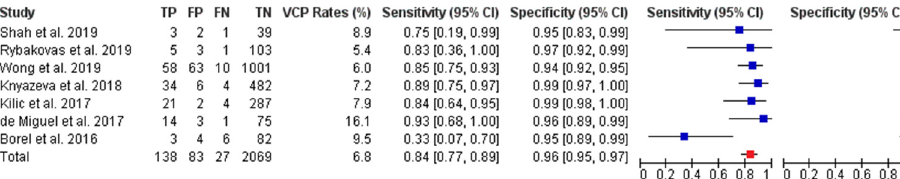
Figure 1. Forest plot of sensitivity and specificity of TLUSG examination in the postoperative period. Blue square indicates the summary estimates for individual studies. Red square depicts the overall summary estimate from all included studies. (TP = true positive, FP = false positive, FN = false negative, TN = true negative VCP = vocal cord palsy rate, CI = confidence interval).